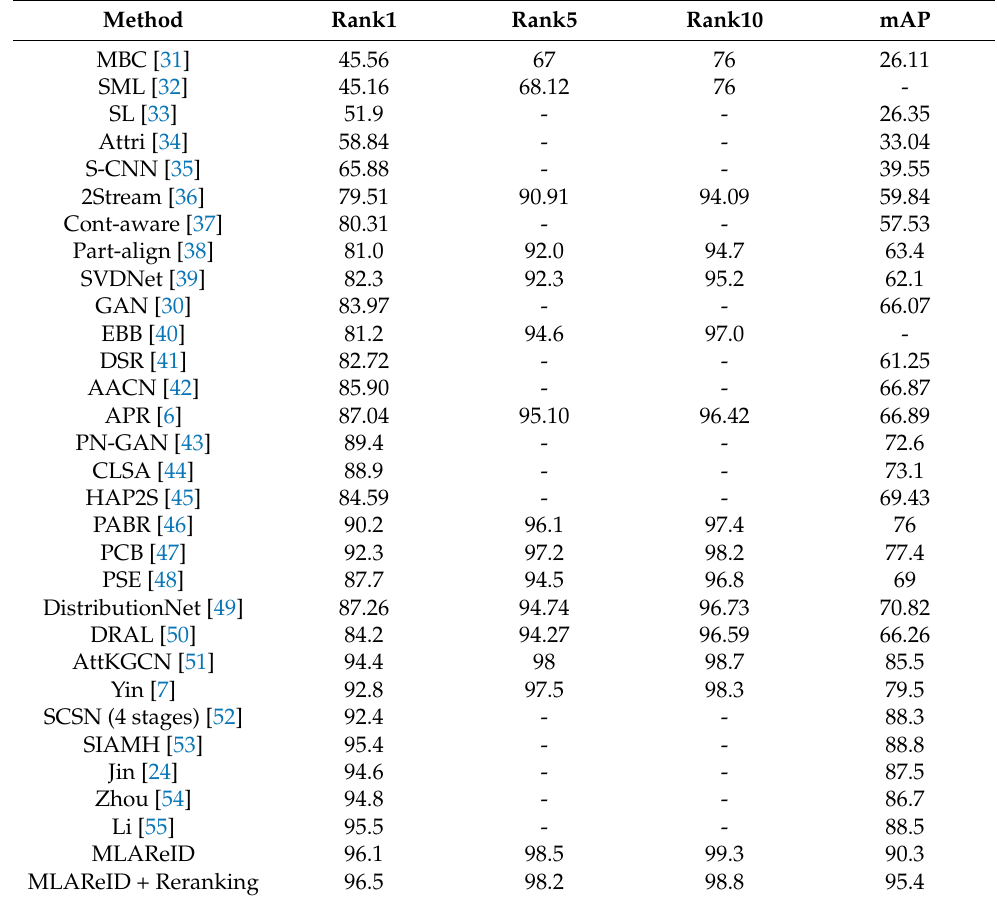
Table 1. Comparison with the state-of-the-art algorithms on Market-1501.